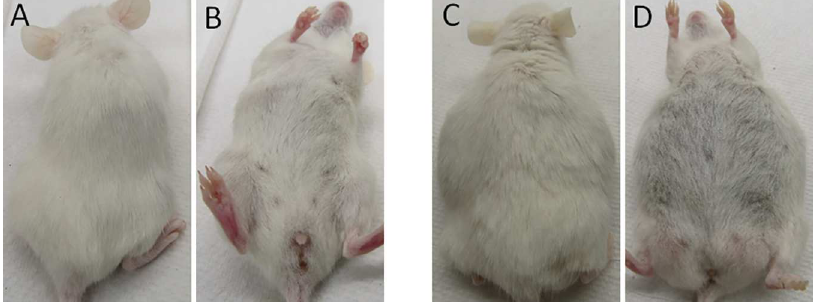
Fig 2. Ascitesin SCID mice after intraperitoneal injection of 5X10 6 cells. (A) & (B) There was no ascites observedin OACM5.1C cells. (C) & (D) Ascites was observed in OE19 cells.